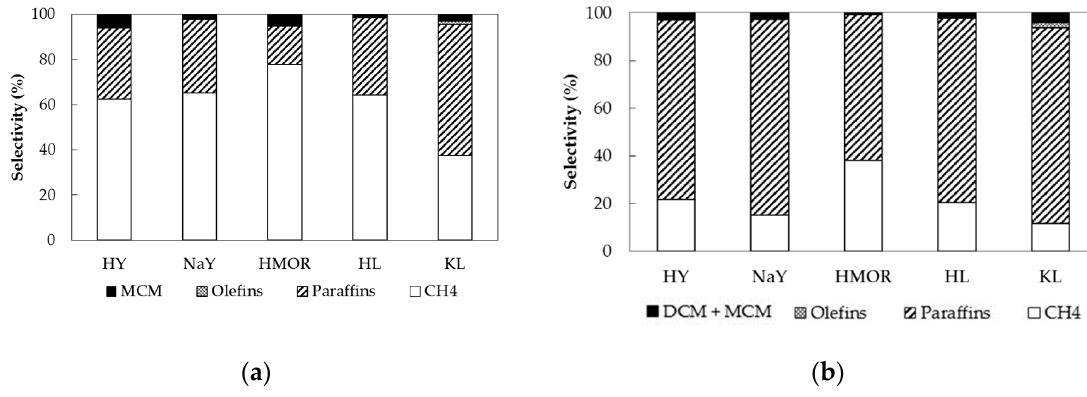
Figure 8. Selectivity distribution in the HDC of DCM ( a ) and TCM ( b ) with the different catalysts (reaction temperature = 300 °C, τ = 0.8 kg h mol − 1 , H 2 /CM molar ratio = 100).